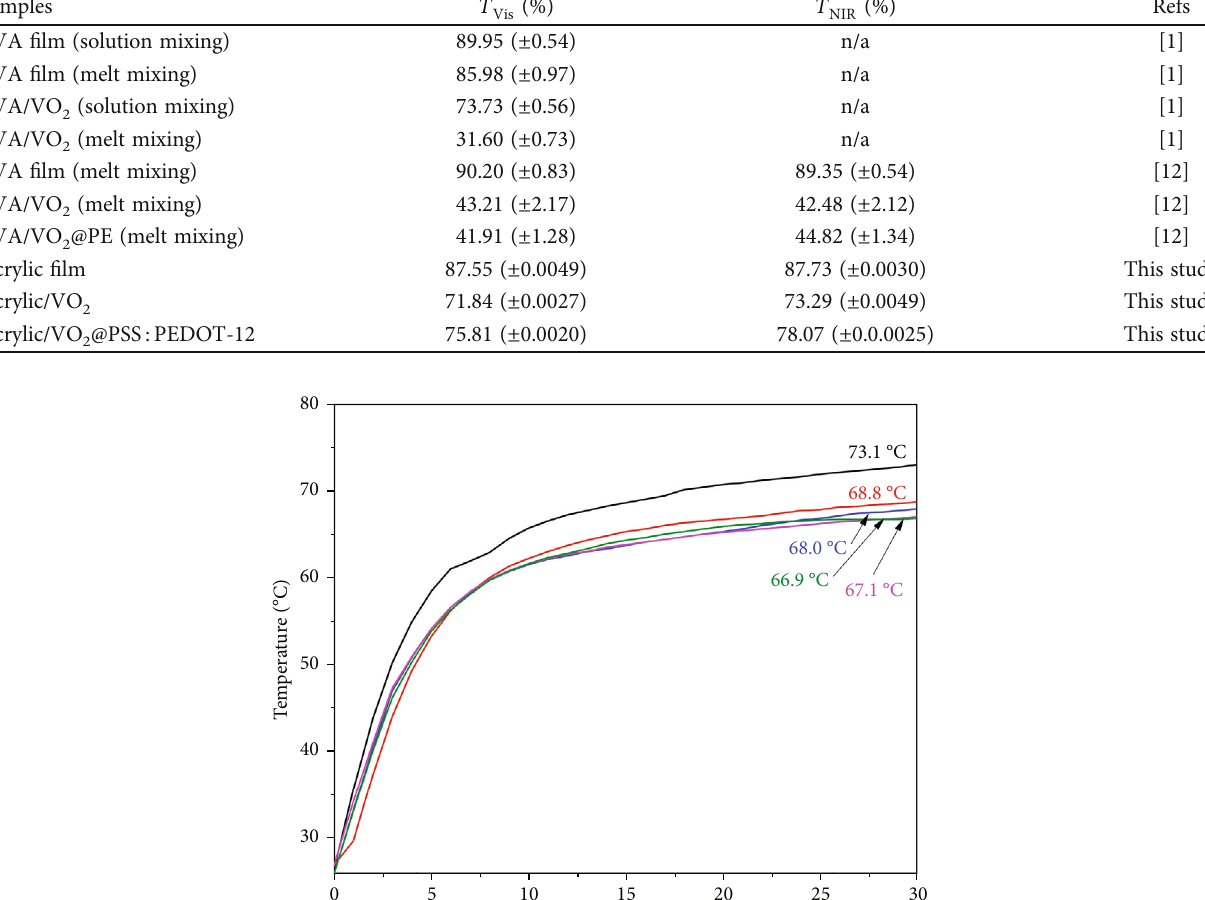
particles (1.0 wt% loading). 2